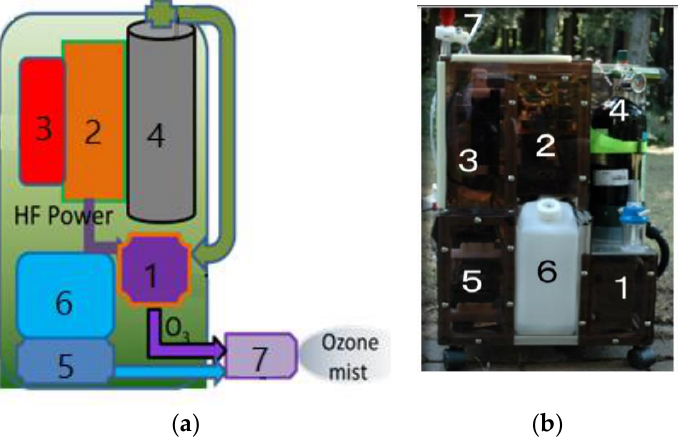
Figure 3. Prototype of the mobile ozone–mist spray system (MOMSS): ( a ) sketch of MOMSS; ( b ) photo of the prototype, where (1) DBD ozone generator, (2) HF inverter, (3) Li-ion battery, (4) O 2 vessel, (5) water pump, (6) water tank and (7) ozone–mist spray. Table 3. Results of the inactivation of plant insects